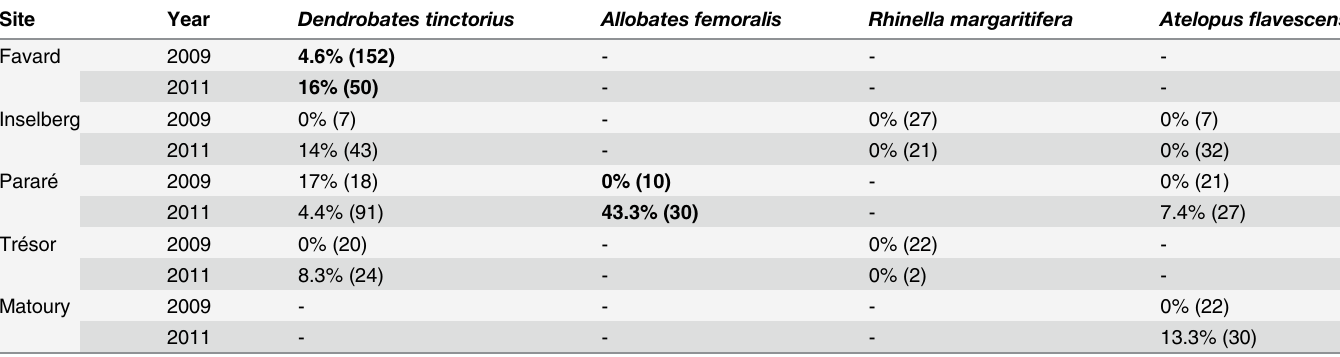
Table 4. Bd prevalence in 2009 and 2011.